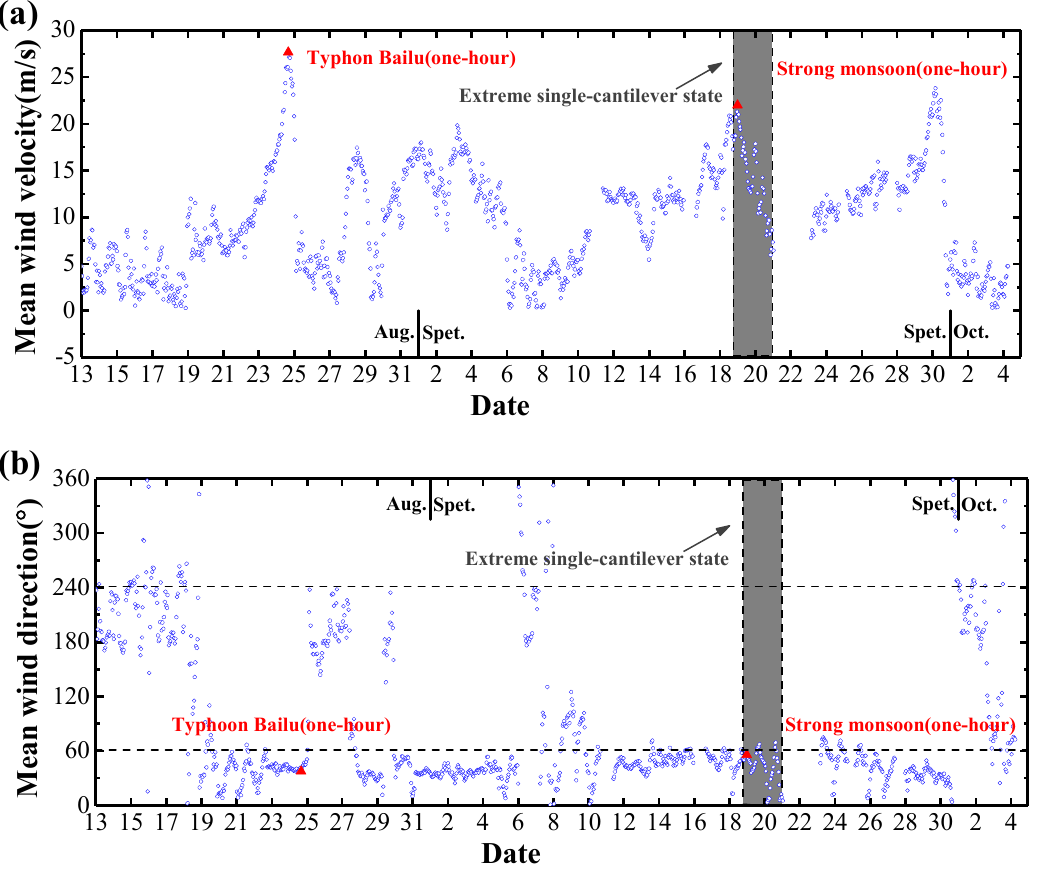
Figure 4. Measured mean wind velocities and directions with a one-hour interval from August 13th to October 5th: ( a ) Mean wind velocity; ( b ) Mean wind direction.